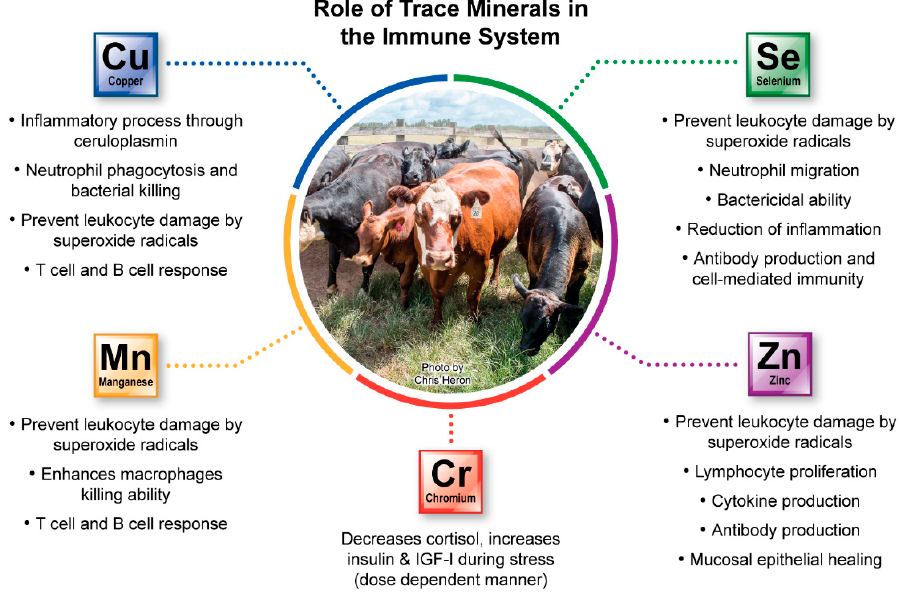
Figure 2. The main roles of trace minerals (TM) in the bovine immune system. Copper, Mn and Zn are structural and functional components of the antioxidant enzyme superoxide dismutase (SOD) and Se is a component of the enzyme glutathione peroxidase (GPx). These enzymes protect leukocytes against membrane damage by free radicals. These TM play important functions mainly in epithelial integrity, leukocyte migration, phagocytosis and bacteria killing, cytokine production, antibody secretion and cell-mediated immunity (CMI).